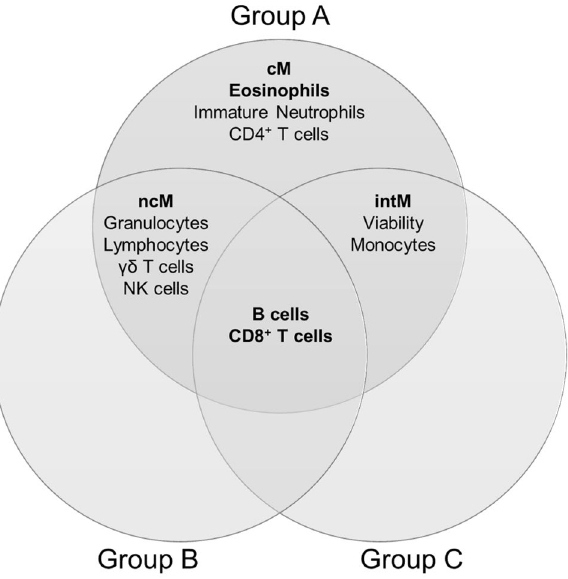
Figure 6. Overview of the most discriminating subpopulations or features of sPLS-DA based on only blood parameters, to separate the treatment phases.